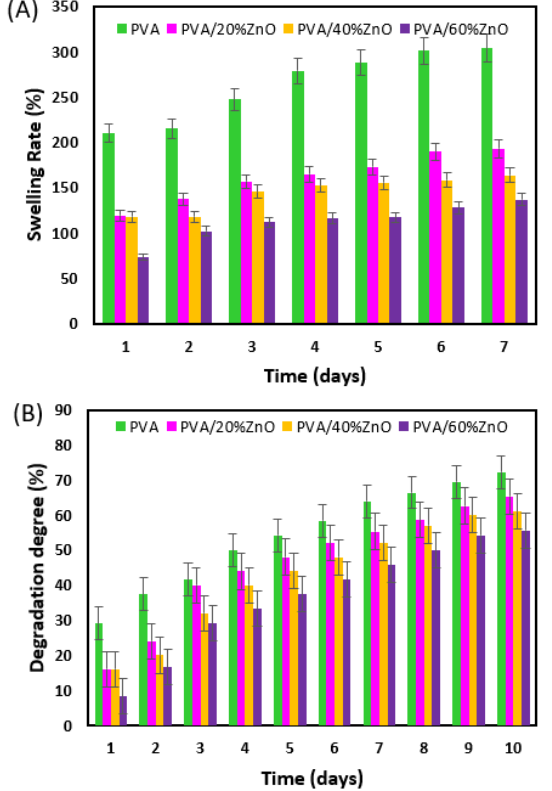
Figure 5. Swelling ( A ) and Degradation ( B ) kinetics of nanofibers in PBS 7.4 at 37 °C.